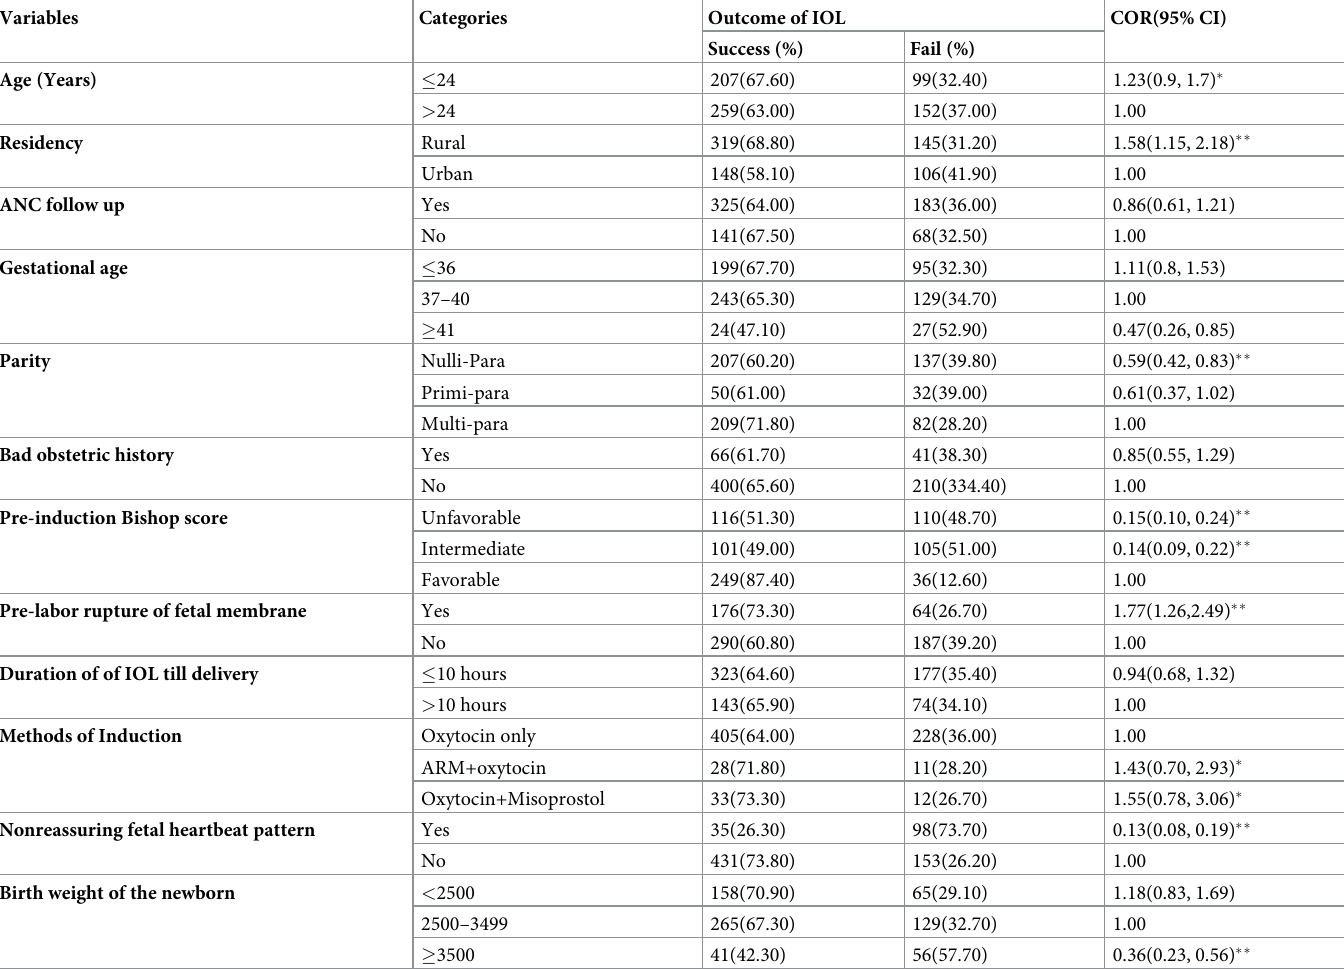
Table 3. Bivariable logistic regression analysis of factors associated with the outcome of induction of labor among mothers who delivered after IOL in public hospi- tals of Harari Regional State, Eastern Ethiopia,